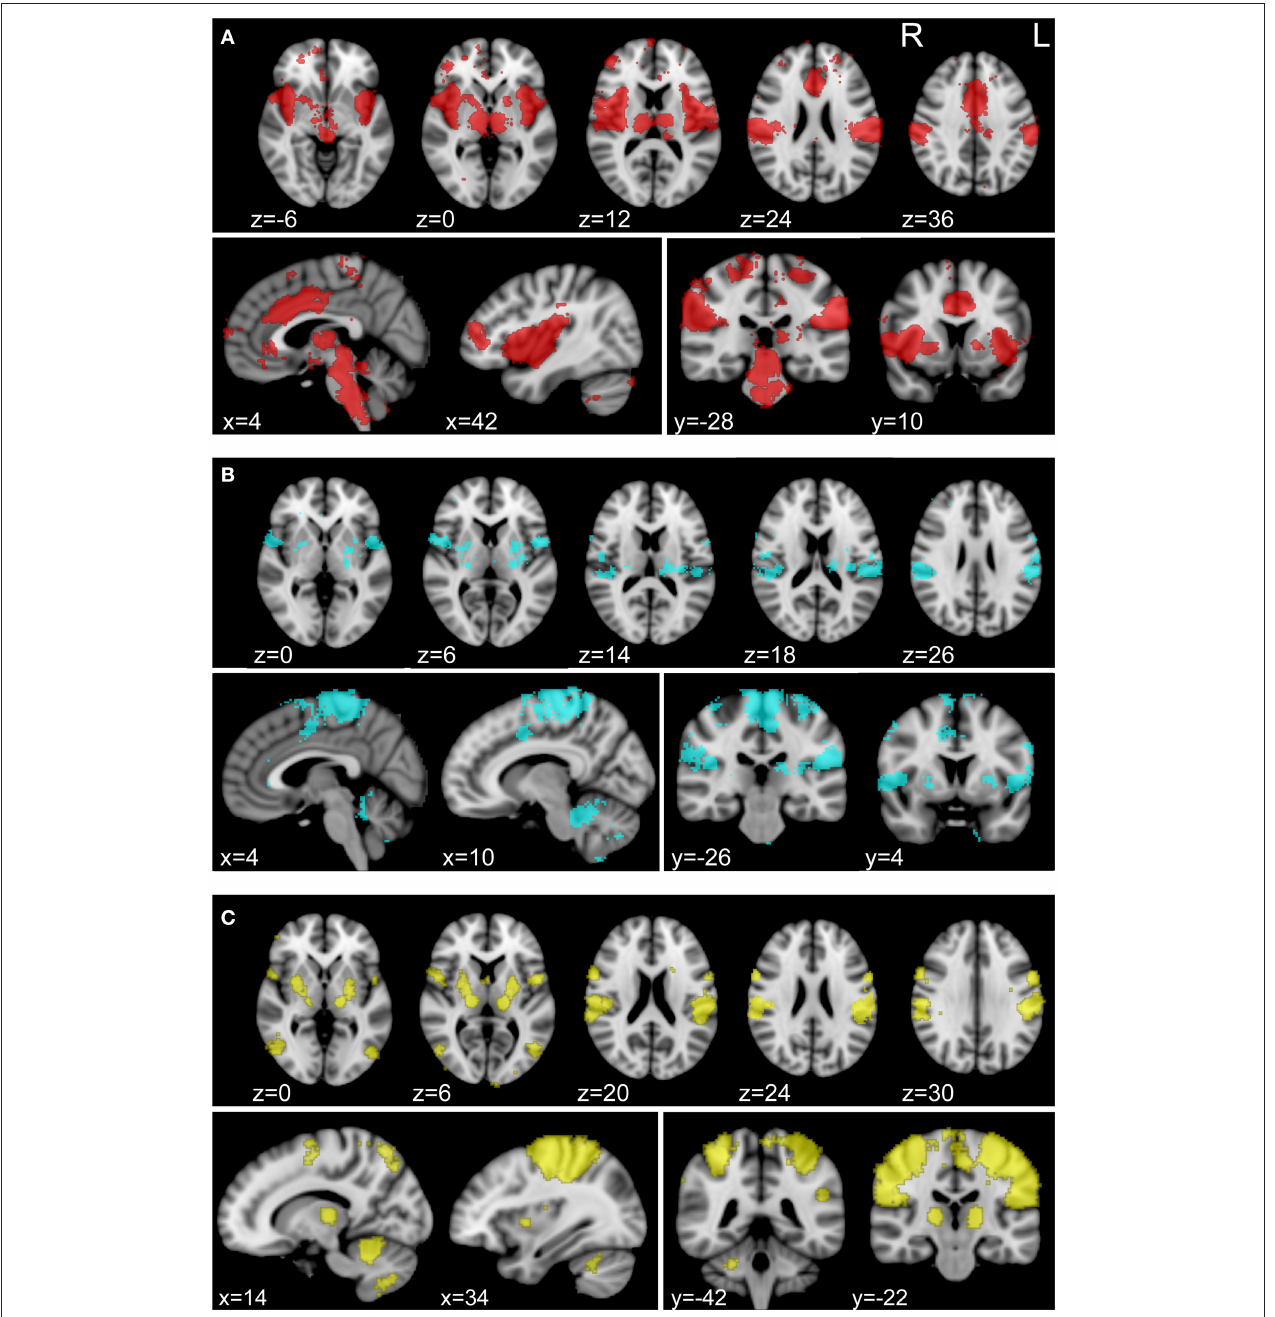
FIGURE 2 | Individually defined association maps used as ROIs for connectivity analysis. Association maps isolated with Neurosynth (neurosynth.org) using “pain” (A) , “foot” (B) , and “hand” (C) as individual keywords. The foot and hand keywords were chosen as correlates for painful and non-painful somatosensory activity, respectively. Selected axial (top row), sagittal (bottom row, left), and coronal (bottom row, right) slices representing the spatial distribution of each functional association area are shown for each keyword. Each association map was treated as an individual ROI for inclusion in our connectivity analysis.